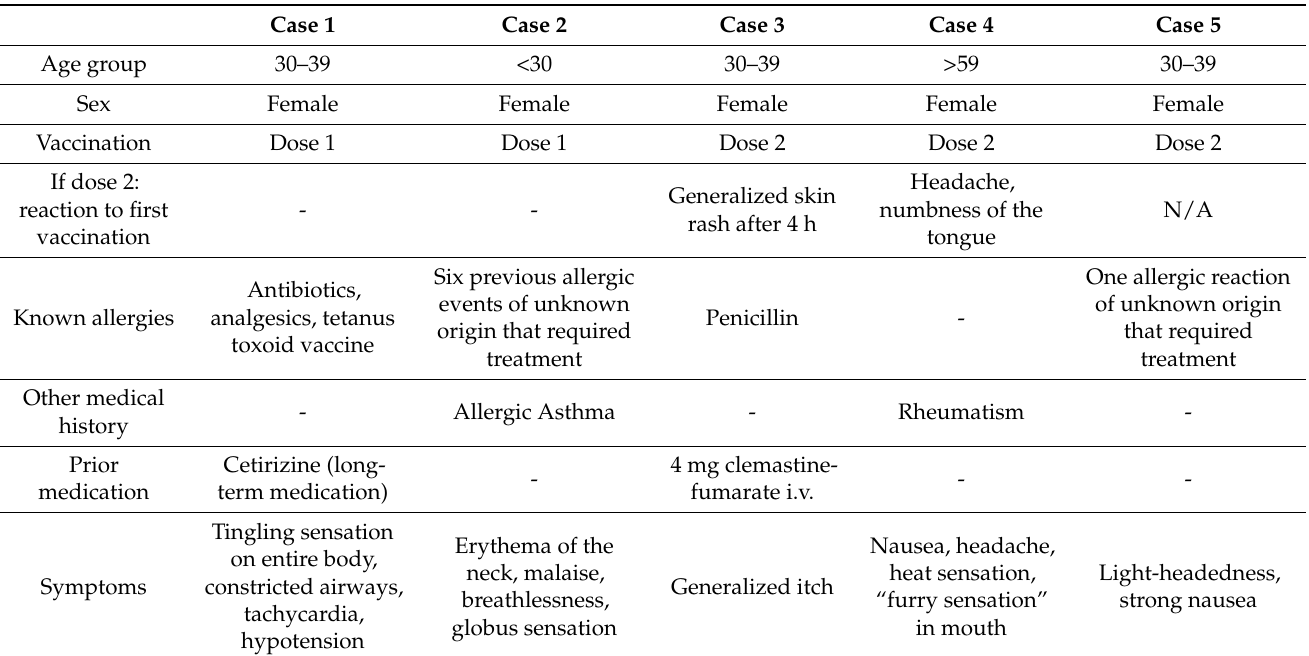
Table 4. Acute complications during the 15-min on-site observation period after the first or second BNT162b2 vaccination.